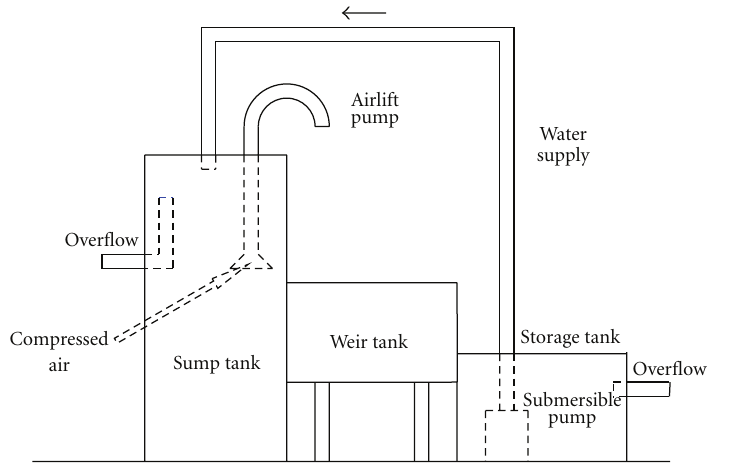
Figure 2: Experimental setup for the airlift pump.